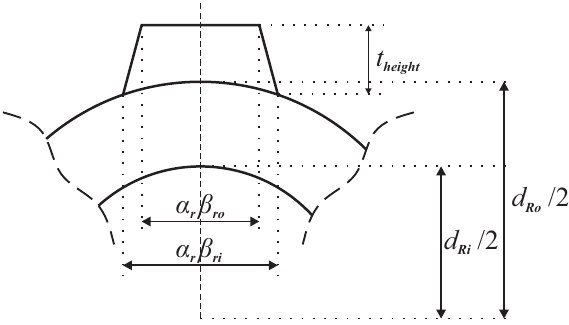
Figure 5. Cross-section of a rotor pole with corresponding